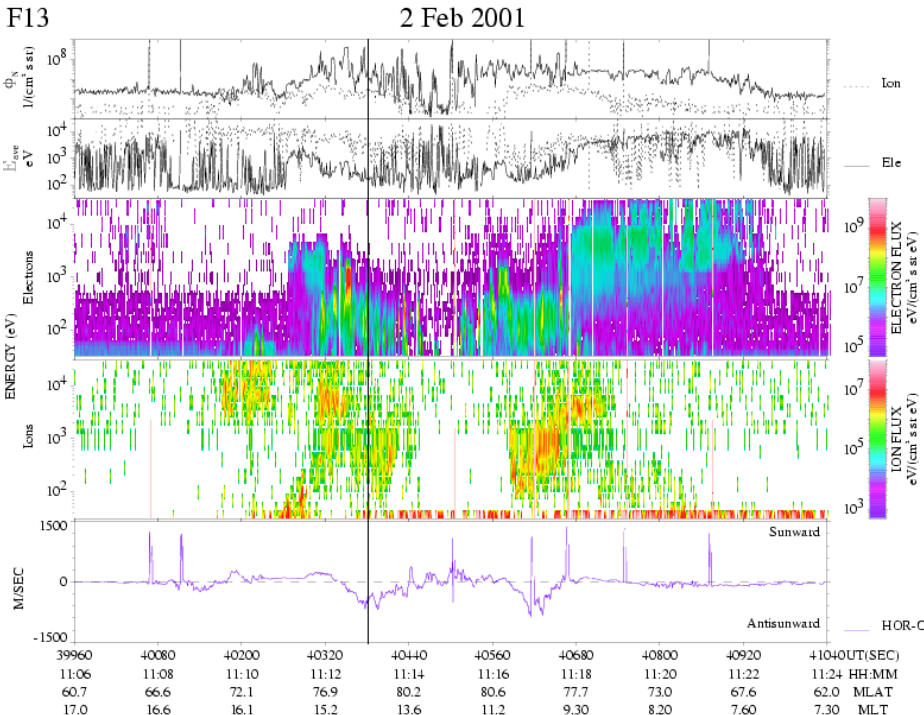
Fig. 9. DMSP data from the SSJ/4 instrument between 11:06 and 11:24UT on 2February2001. The black vertical line marks the conjunction with the